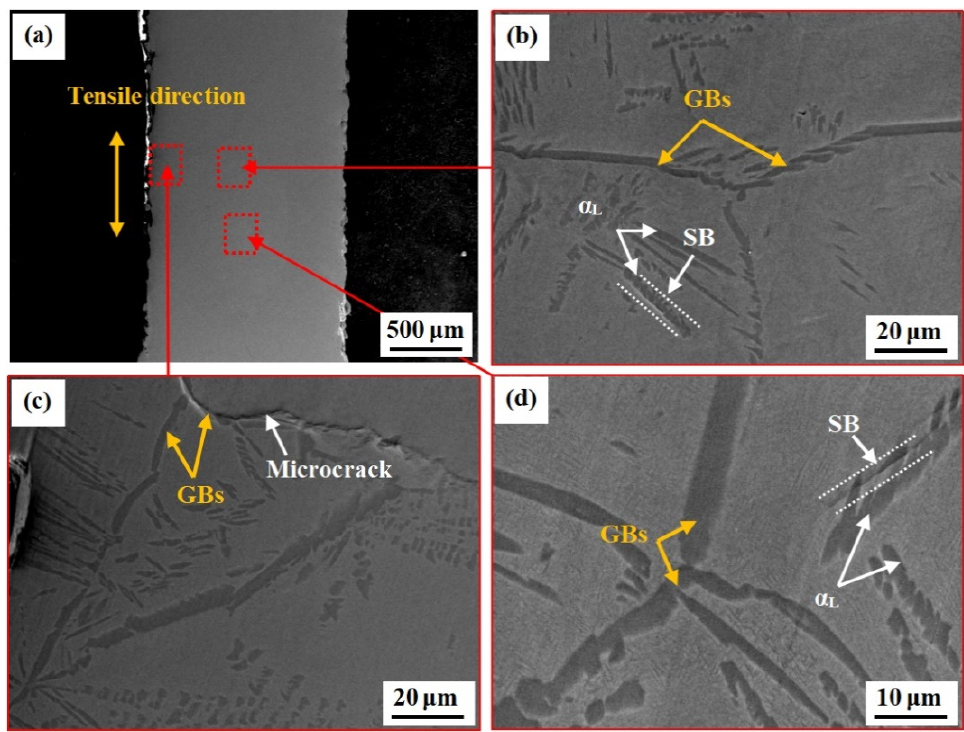
Figure 8. ( a ) In situ SEM images of lamellar microstructure at A’ (the displacement of 661 µ m); ( b , d ) magnified image showing SBs develop in the α L phase near GB; ( c ) magnified image showing microcracking in a long, coarse α L phase at a trigeminal GB.